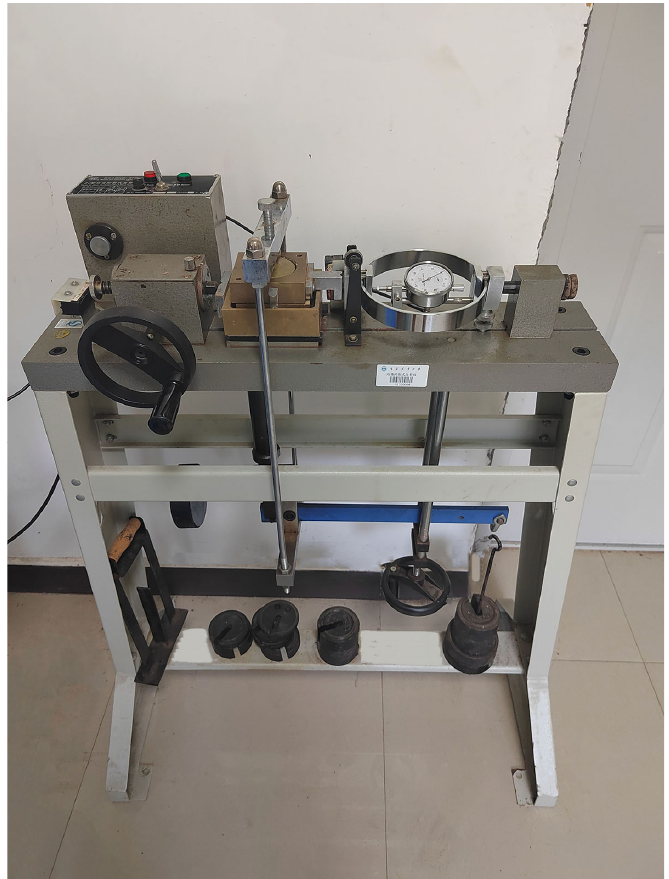
Figure 7. ZJ strain ‐ controlled direct shear apparatus [22]. Figure 7. ZJ strain-controlled direct shear apparatus [22].